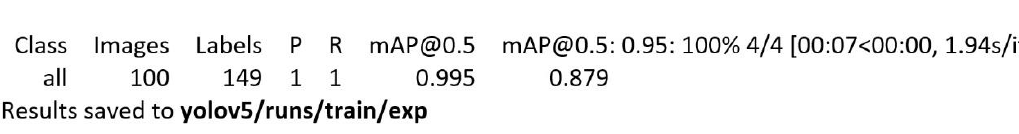
Figure 13. Floating mine detection model YOLOv5.